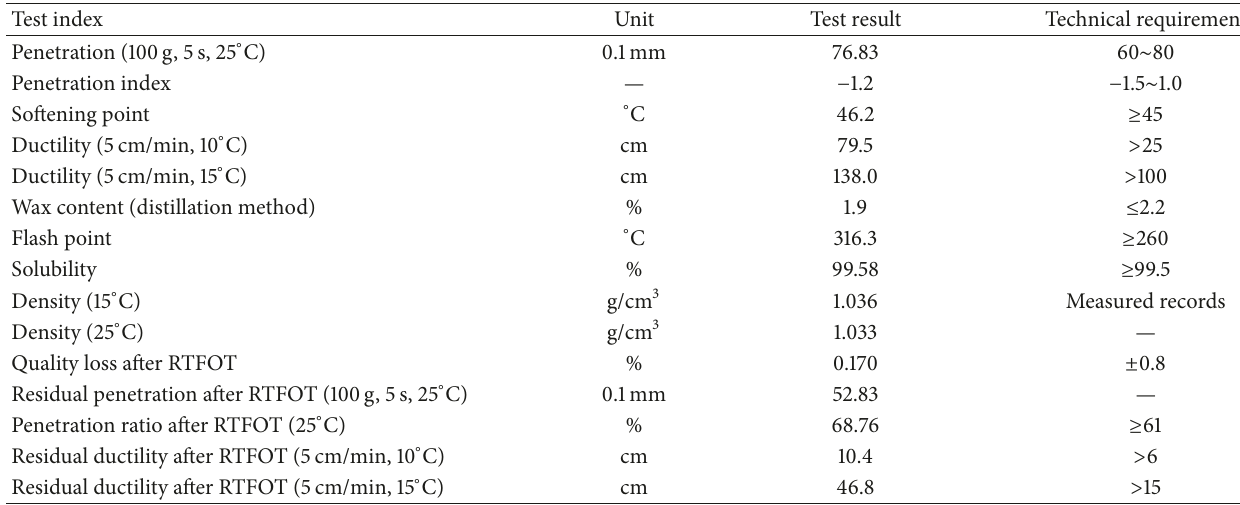
Table 1: Technical properties of Shell 70 matrix asphalt.